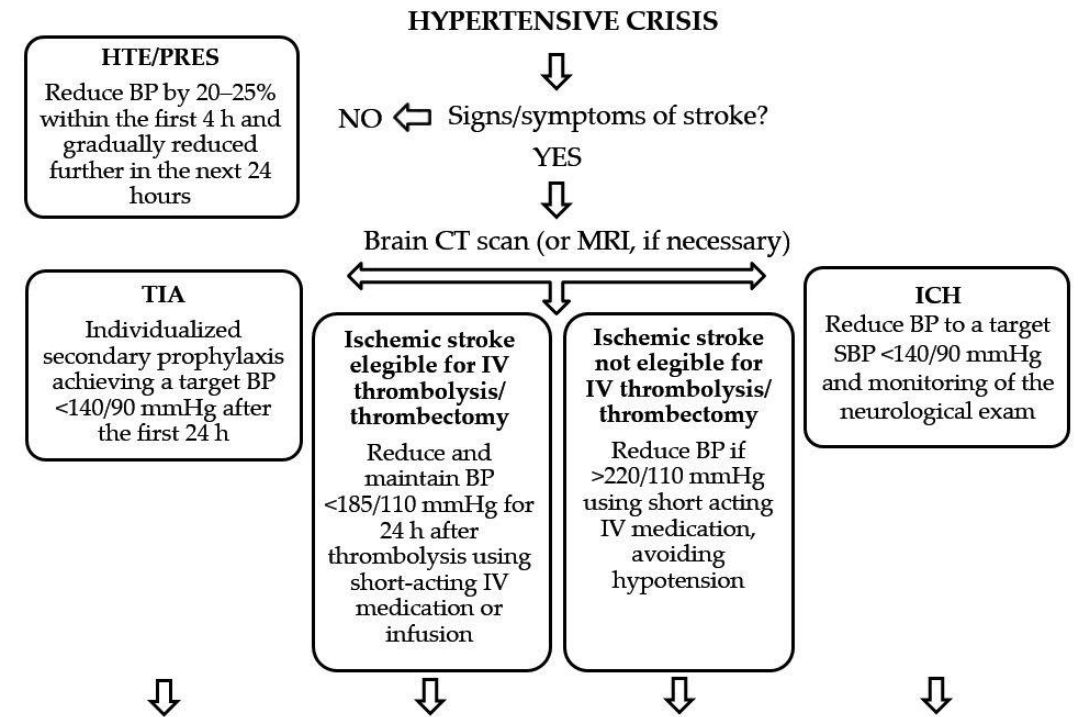
Figure 2. Proposed schematic algorithm to guide the management of blood pressure in patients with TIA, ischemic stroke, and ICH presenting at the emergency department. Legend (in alphabetic order): BP: blood pressure; CT: computed tomography; h: hours; HTE: hypertensive encephalopathy; ICH: intracerebral hemorrhage; IV: intravenous; MRI: magnetic resonance imaging; PRES: posterior reversible leukoencephalopathy syndrome; TIA: transient ischemic attack.